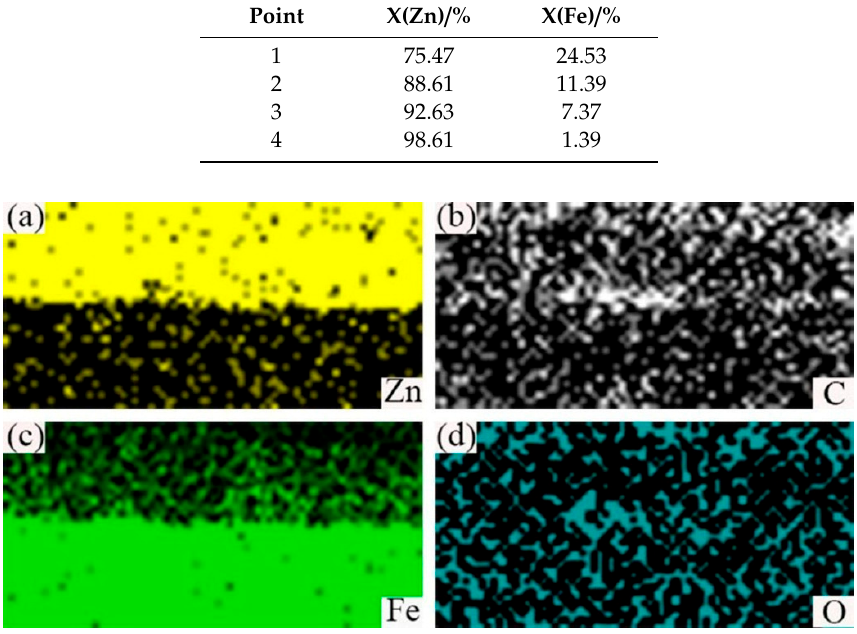
Figure 4. EDS maps scan of the cross-section image of hot-dip galvanized 45 steel marked in Figure 3a. ( a )EDS map of Zn element; ( b ) EDS map of C element; ( c ) EDS map of Fe element; and ( d ) EDS map of O element.